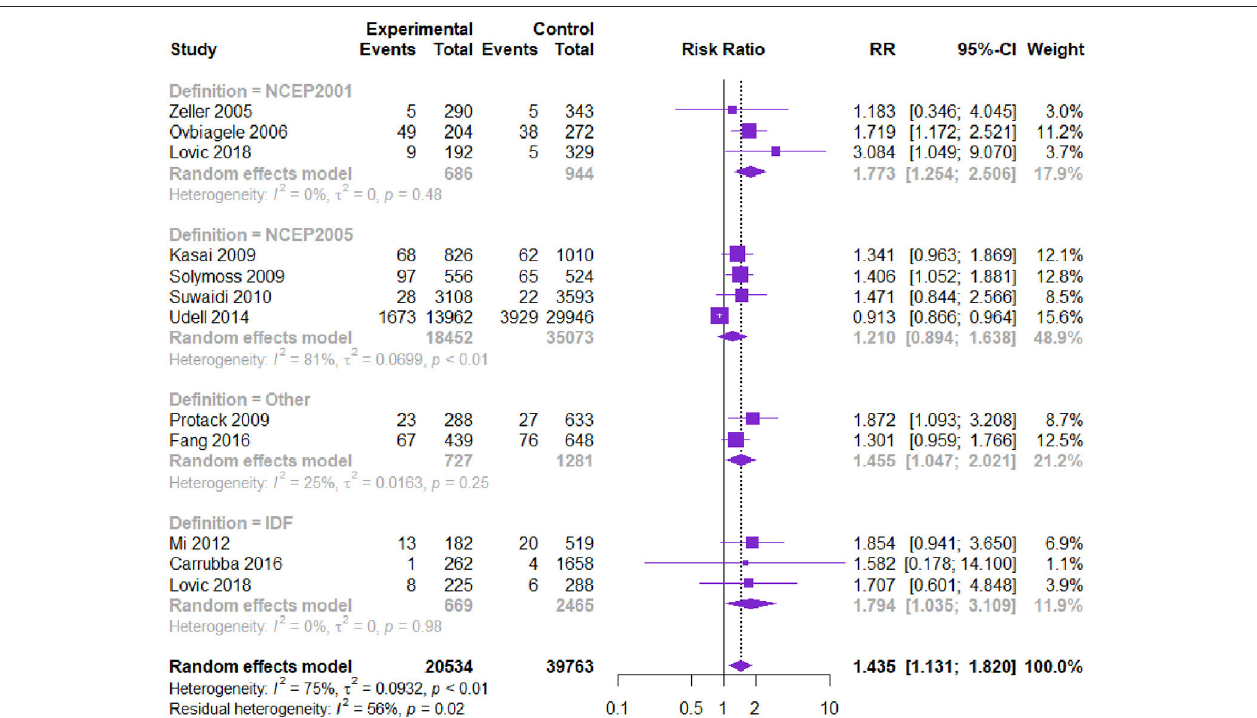
FIGURE 5 | Meta-analysis of the risk of stroke in patients with CVD and MetS compared with that of patients without MetS.